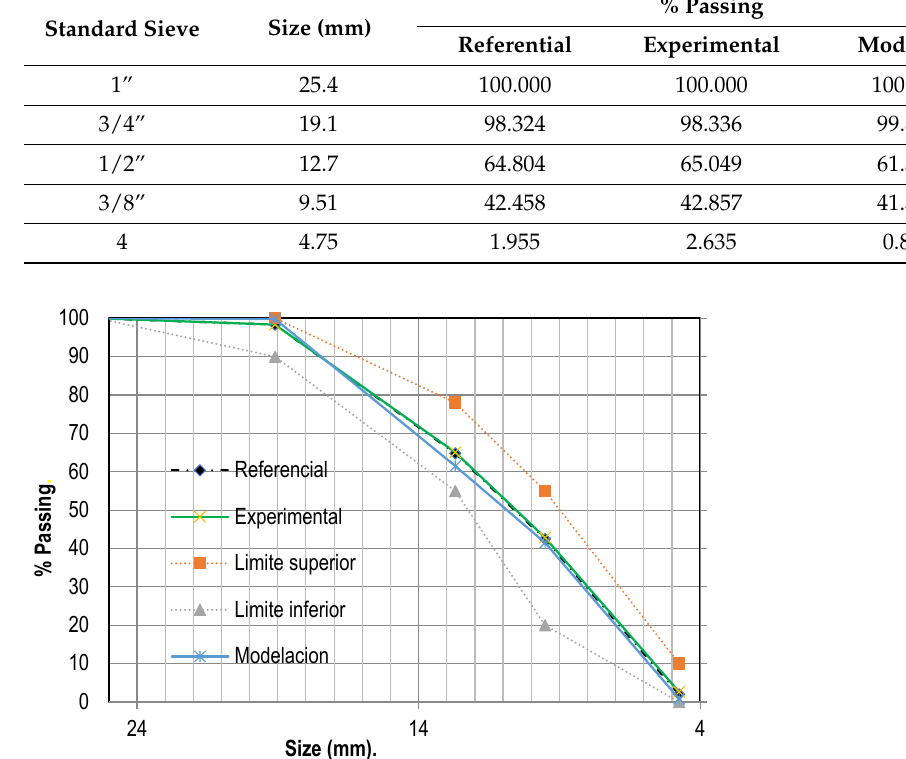
24.524 Figure 7. Modeling results vs. experimental value. Modulus of elasticity. In the final part of the computational model, the plastic behavior was added to the elastic behavior previously worked on, for which it was necessary to add the characteristic data of the yield zone that corresponded to stresses and deformations in the plastic range for each material previously obtained in the test part. In this way, the cylinder was